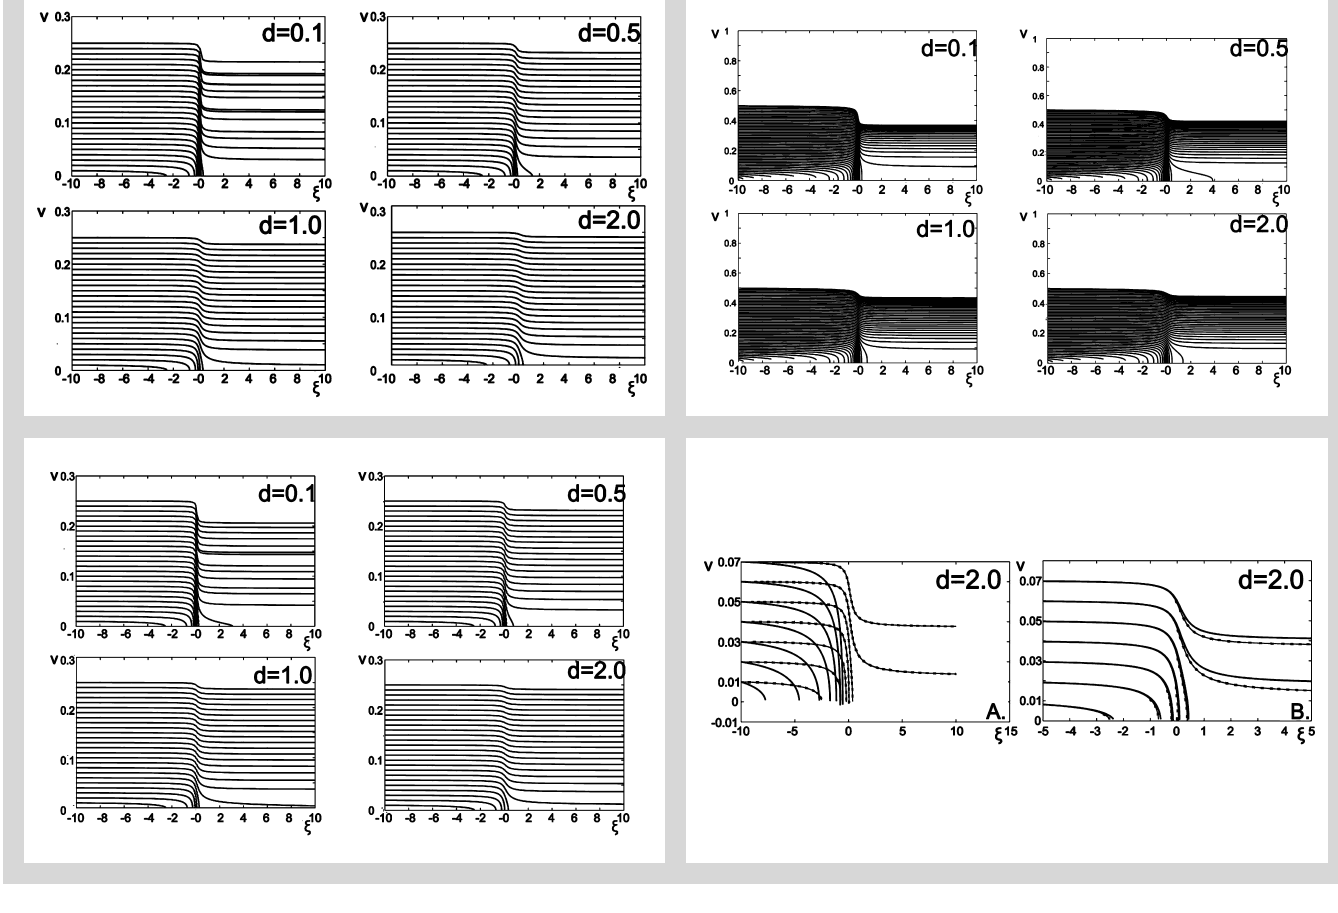
Figure 2 (left above): Trajectories of nanoparticles in a laminar, stationary flow profile of a Newtonian fluid for different distances between magnetic field source and vessel. Figure 3 (right above): Trajectories of nanoparticles in a laminar, stationary flow profile of a non-New- tonian fluid for different distances between magnetic field source and vessel. Figure 4 (left below): Trajectories of nanoparticles in an oscillatory flow profile of a Newtonian fluid for dif- ferent distances between magnetic field source and vessel. Figure 5 (right below): (a) b = 0.0007 (dashed line) and b = 0.007 (solid line) at d = 2 and (b) d = 0.04 (dashed line) and d = 4 (solid line) at d =